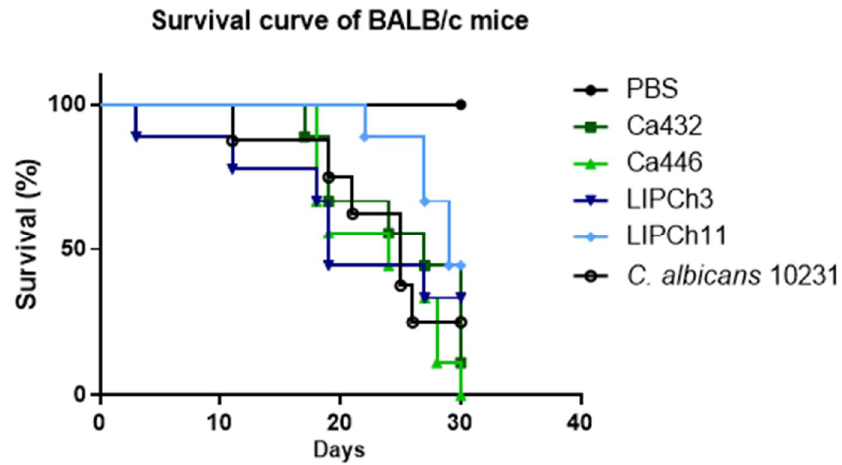
Figure 5. Animals ( n = 10 / group) were immunosuppressed with cyclophosphamide and infected with 10 4 yeasts of C. auris (Ca432 and Ca446), C. haemulonii complex (LIPCh3 and LIPCh11) or C. albicans 10,231 (control group). Animal survival was observed for 30 days after infection. Significance compared to PBS-inoculated group (Long-rank test, p < 0.05). Data are representative of three independent experiments.